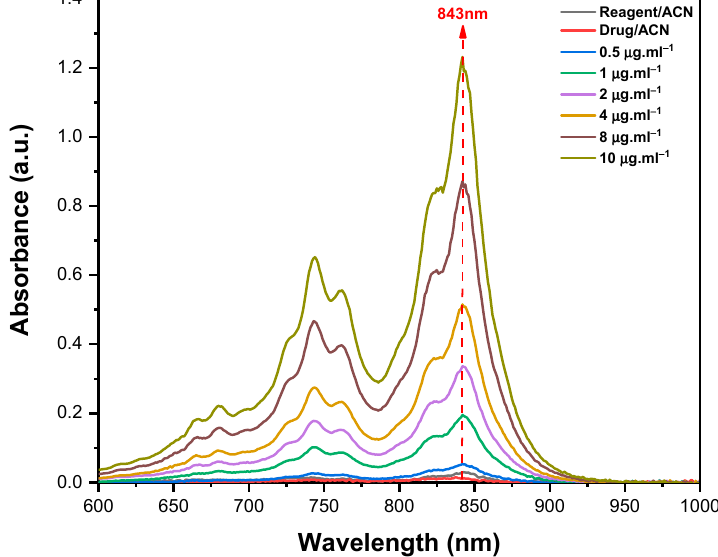
Figure 1. Absorption spectrum for the TIGC-TCNQ CTC obtained under conditions of Temp = 50 °C, RV = 1.5 mL, RT = 60 min, and DS: ACN. Spectra were drawn against a reagent blank (TCNQ